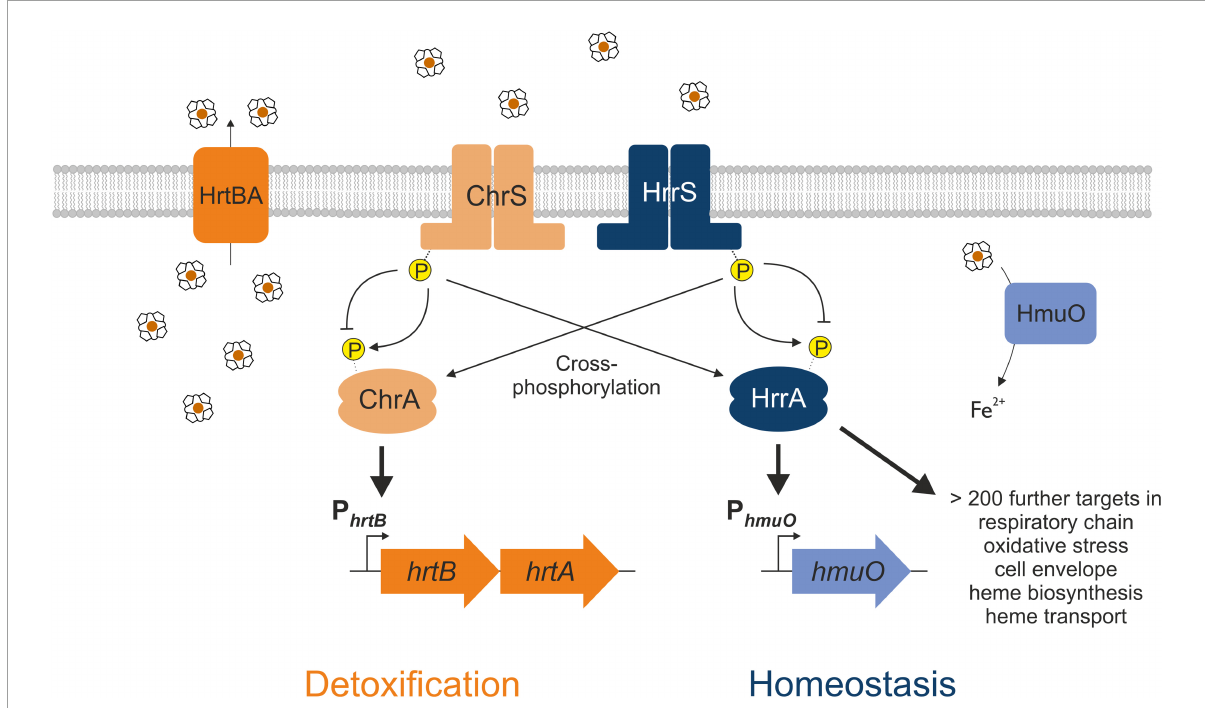
FIGURE1 Interaction between the two heme-responsive two-component systems (TCS) ChrSA and HrrSA in Corynebacterium glutamicum . The simplified schematic representation shows the interaction of the two TCS ChrSA (orange) and HrrSA (blue) and each one representative target gene. ChrSA is solely responsible for the detoxification from heme via activating the hrtBA operon and autoregulates its own expression (Heyer et al., 2012). The HrrSA system was recently shown to act as regulator for heme homeostasis, controlling hmuO as well as more than 200 further genes involved in heme biosynthesis, respiratory chain, oxidative stress, or cell envelope remodeling (Keppel et al., 2020). The histidine kinases ChrS as well as HrrS undergo autophosphorylation in response to heme, activating the respective response regulator ChrA and HrrA. Cross-phosphorylation of the non-cognate response regulator has been demonstrated, while the phosphatase activity remains specific for the respective cognate response regulator (Hentschel et al.,